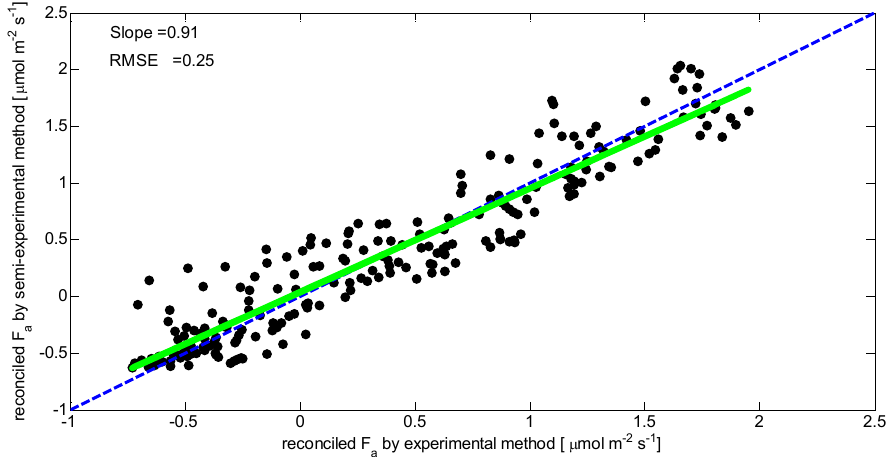
Figure 9. Cross validation of reconciled F a by two methods, utilizing a linear regression curve (the green line). The diagonal blue line is taken as a reference. Table 3. Fitted relationships between isolated components by two methods.